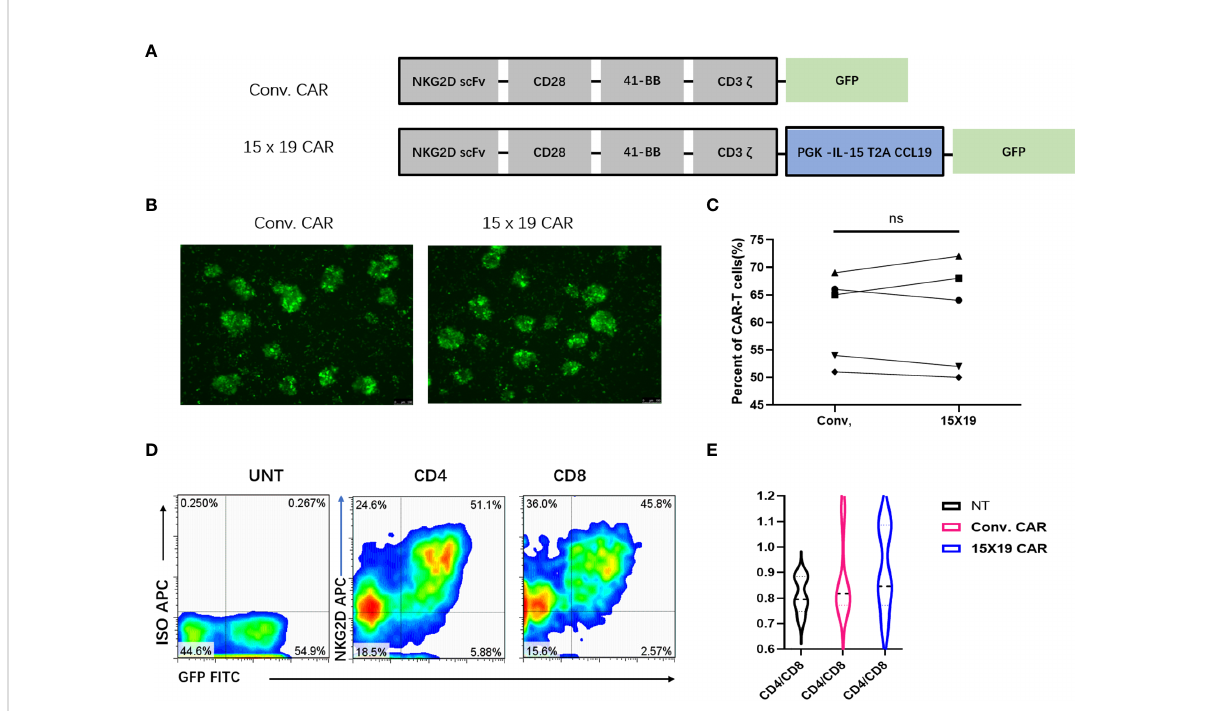
FIGURE 2 Generation of a speci fi c CAR construct and in vitro expansion of CAR T cells. (A) The conventional CAR construct contains the extracellular region of human NKG2D receptor, which links with the transmembrane region and intracellular region of CD28, and the co-stimulatory domain of intracellular CD137 (4-1BB) and CD3 z signal motif. The IL-15/CCL19 sequences-conjugated PGK promoter with 2A sequence embedding is introduced to conventional CARs to generate 15 × 19 CARs, which present the fl uorescence of GFP; (B) , Green fl uorescence is present in conventional CAR T cells and 15 × 19 CAR T cells 72 hour post-infection; (C) , No signi fi cant difference is seen in the cell transduction ef fi ciency (both > 50%) between the conventional and 15 × 19 CAR groups. Analyzed for statistical signi fi cance by paired Student ’ s t test ( P =0.8712); (D) , Expression of NKG2D (APC)-positive and GFP-positive CAR T cells in CD4 + and CD8 + T cells. Representative density plots are created from fi ve independent experiments; (E) , There is no signi fi cant difference in the CD4/CD8 ratio among the three groups ( P > 0.05). Data are captured from three independent healthy